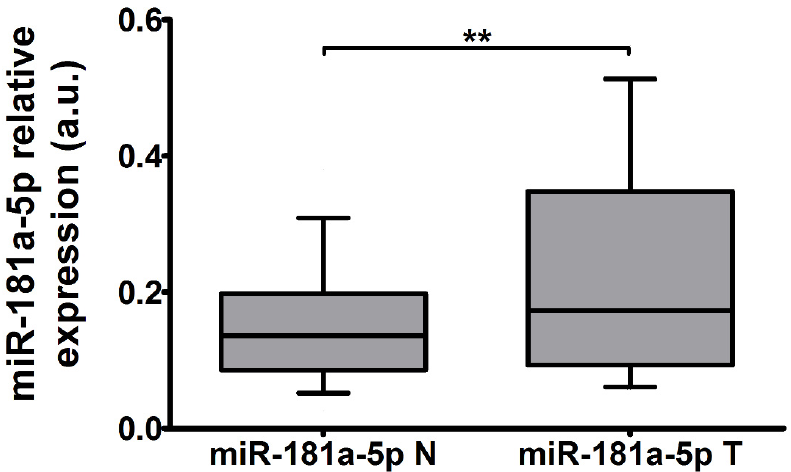
Figure 2. The expression of miR-181a-5p normalized to U44 in PTC-T versus PTC-N tissue ( n = 49). The expression was increased by 27% ( p = 0.0015). Data are expressed as median and 10–90 percentile. Statistical analysis was performed with a Wilcoxon t -test to compare expression of miRNA in PTC-T vs. PTC-N tissue, ** p < 0.01.